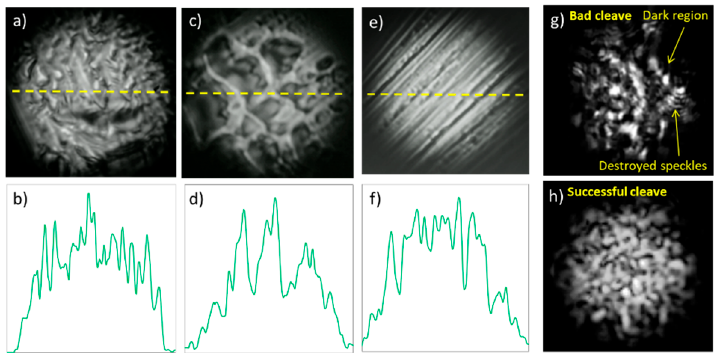
Figure 3. Comparison of microscopic image ( a – c ) and near-field pattern ( d ) end-face inspection methods: the near-field profile pattern demonstrates defects ( d ) that can be missed by the microscopic image ( b ). ( a ) cleaved end-face, ( b ) CYTOP core-cladding region, ( c ) CYTOP core-cladding region when white light was launched into the fiber, ( d ) near-field intensity pattern.